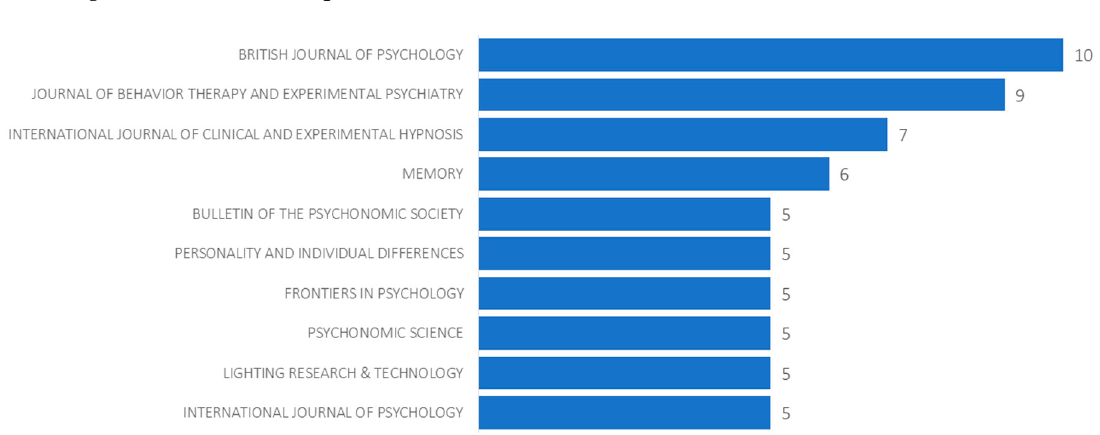
Figure 3. Top 10 journals publishing documents with “vividness” in the title.